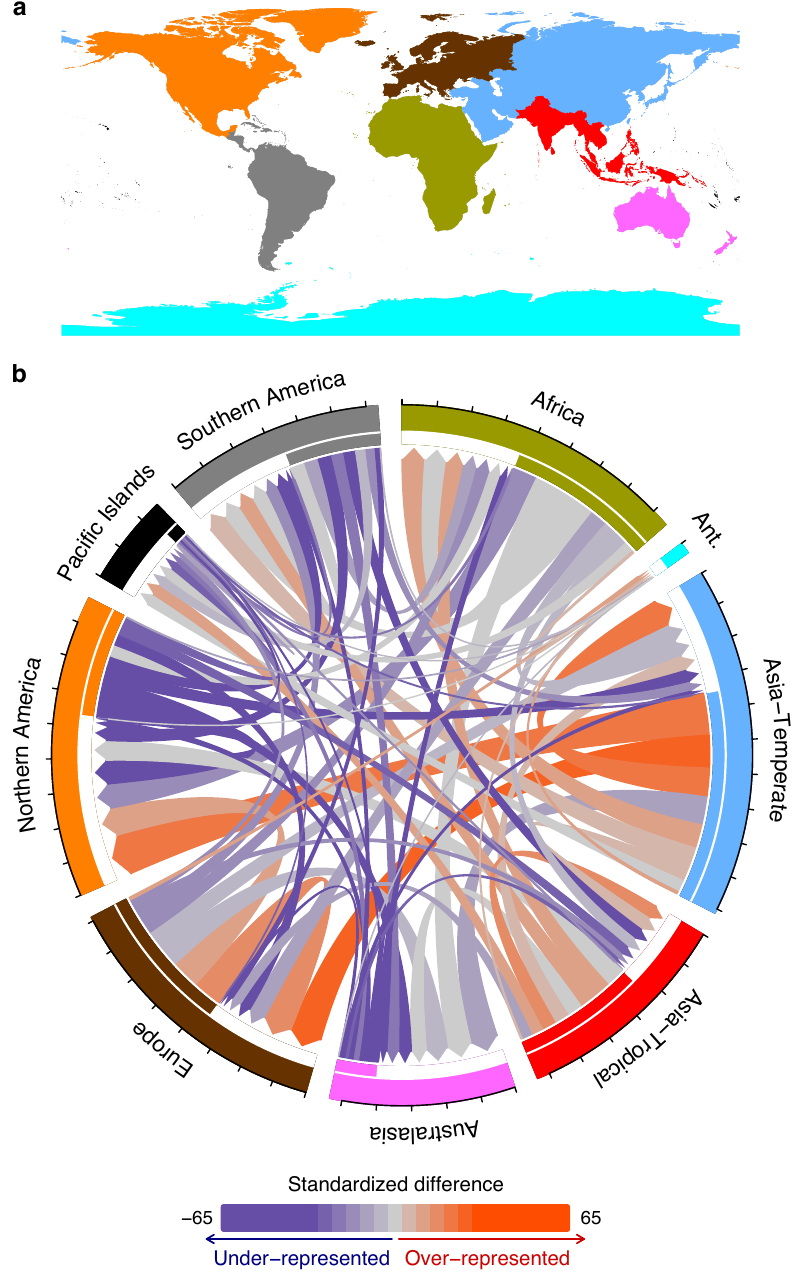
Fig. 6 Flows of naturalized economic plants among the TDWG continents. a Map of the TDWG continents. b Flow diagram in which the outer circle shows the cumulative number of naturalized economic plants that a continent has donated to other continents (or to itself) and received from those continents. Each tick interval along the outer circle corresponds to 1000 taxa. The colors of the fl ow arrows indicate whether the fl ows are larger (red color tones) or smaller (blue color tones) than expected based on random sampling (see Supplementary Fig. 6 for which fl ows are signi fi cantly larger or smaller than